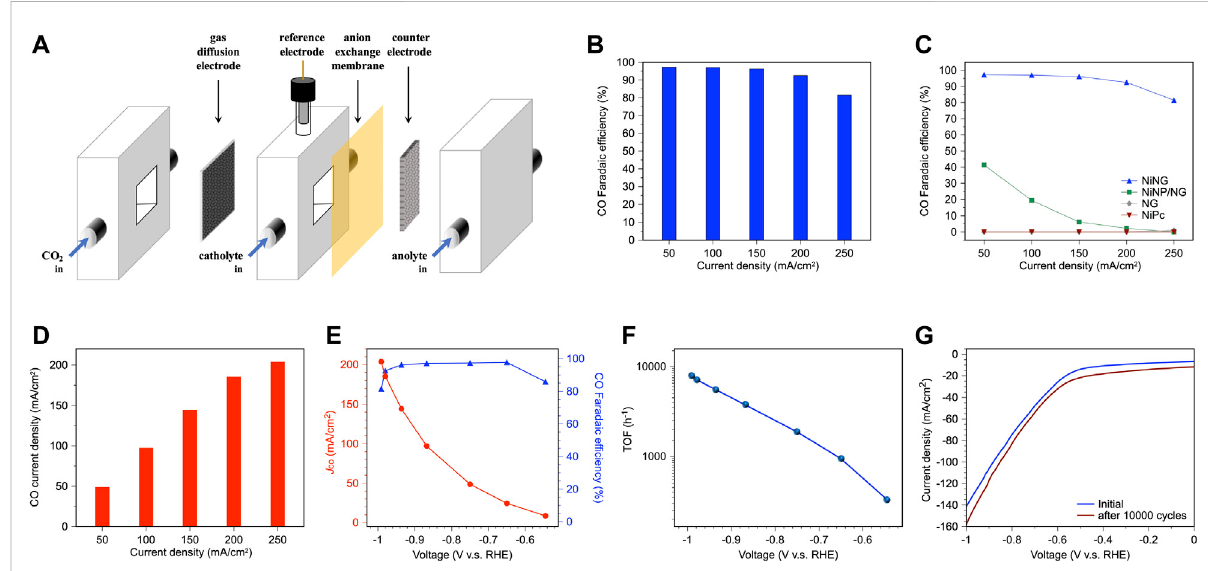
FIGURE 3 Catalytic performance of NiNG in the fl ow cell. (A) Schematic illustration of the fl ow cell. (B) CO faradaic ef fi ciency of NiNG at various current densities for CO 2 RR. (C) The comparison of CO faradaic ef fi ciency of NiNG with NiNP/NG, NG, and NiPc. (D) CO current density of NiNG at various current densities for CO 2 RR. (E) CO Faradaic ef fi ciency and partial current density vs. applied potential of NiNG with the loading amount of 1.5 mg/cm 2 . (F) TOF of NiNG for CO production of CO 2 RR. (G) Polarization curve of NiNG during CO 2 RR before and after 10,000 CV